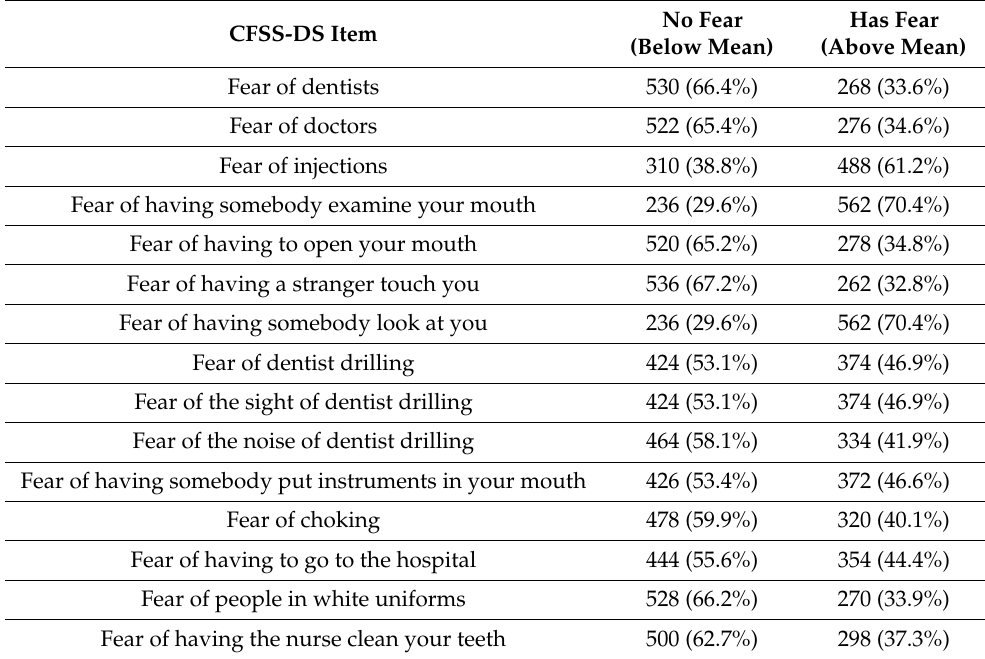
Table 2. Dental fear among children assessed using the CFSS-DS tool (N =